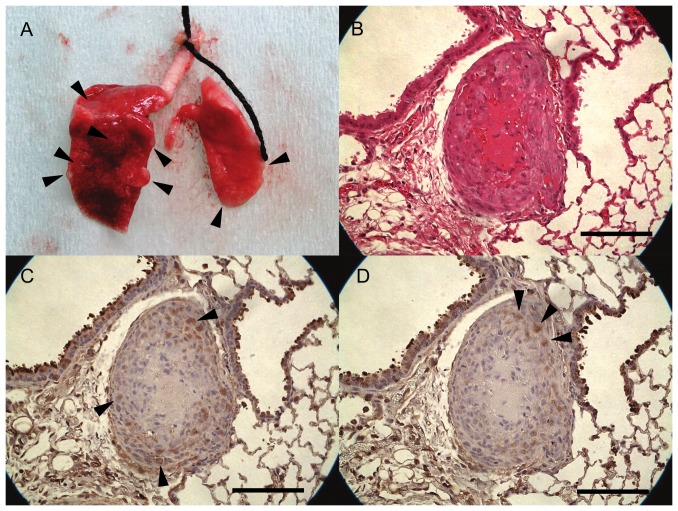
Tumors which grew along the intimal surface of the pulmonary arteries.(A) A resected lung from a mouse. SCID mice were sacrificed 28 days after the injection of SCLs. Many nodules were located on the surface of the lungs. Arrow heads showed some of these nodules. (B) HE staining showed that the tumors were composed of a central area with necrosis and a peripheral zone filled with SCLs. (C) Immunohistochemical staining for MMP-14 revealed that the peripheral area of tumors was positive for MMP-14, and the central necrotic area was negative for MMP-14. (D) Immunohistochemical staining for MMP-2 showed that MMP-2 was weakly positive in the peripheral zone. (Scale bars show 100 µm.)